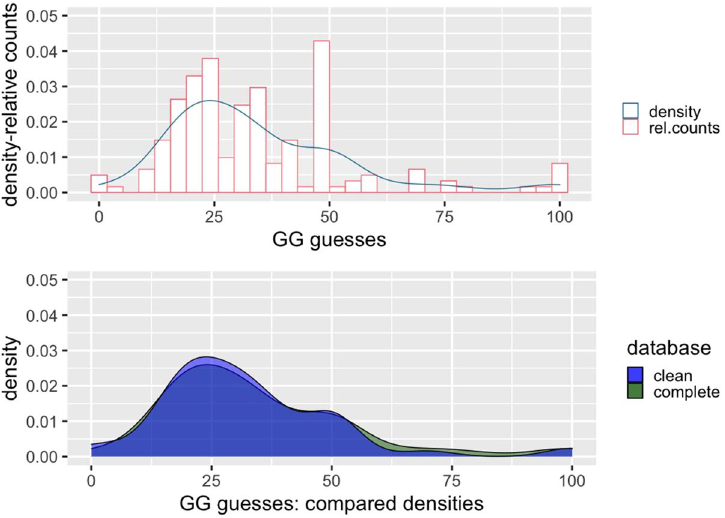
Figure 1. Top: histogram of choices in the guessing game, counts and density. Bottom: Density distribution of choices comparing complete database and clean (i.e., excluding random guesses).